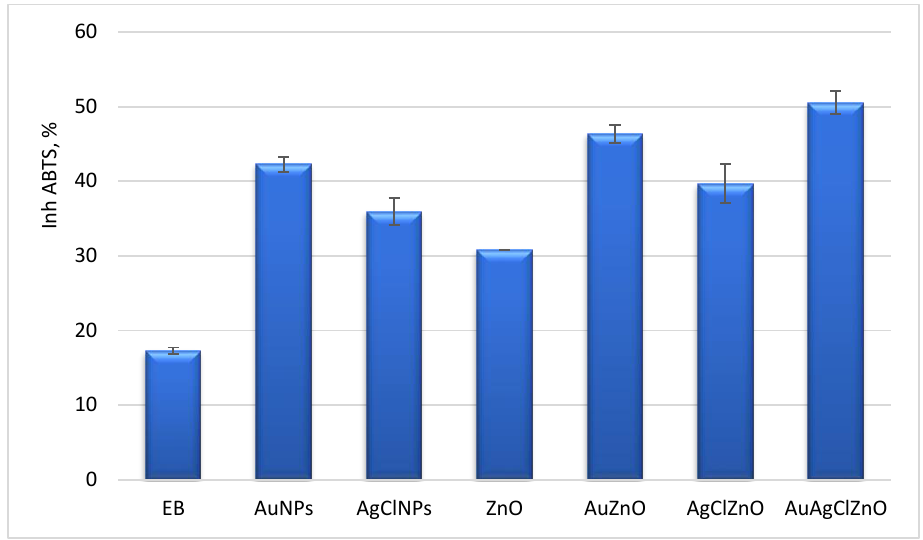
Figure 10. The scavenger activity of ABTS •+ by phytometallic particles.